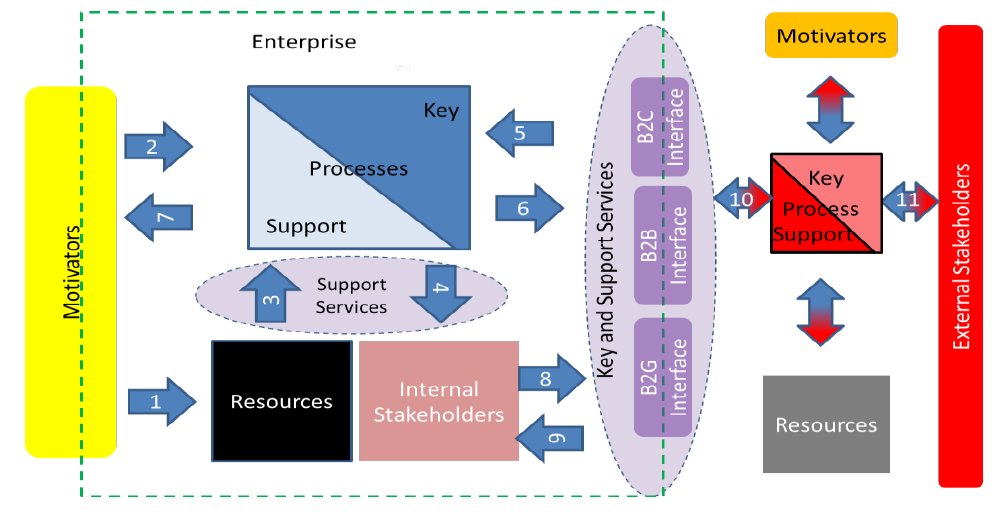
Figure 4. Proposed holistic layer of the enterprise architecture based on process approach Motivators are shown as a yellow box on the left hand side while part of the box is inside the green square and the rest is outside of it. It reflects the architecture of motivators in a real